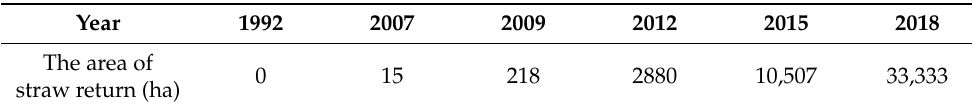
Table 2. The area of straw return in Lishu County in different